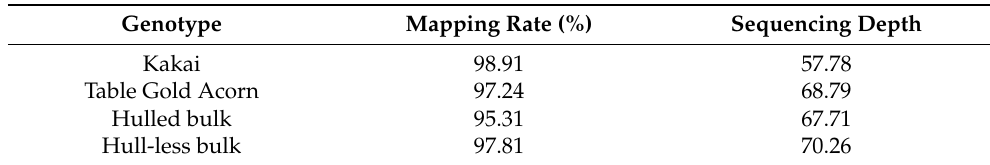
Table 2. Whole genome resequencing statistics for hull-less and hulled parents and the bulks used in the study.